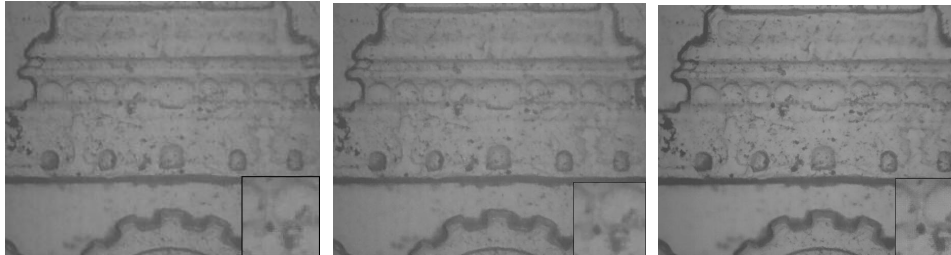
Figure 13. Experimental result. ( a ) low-resolution thermal microscope image (SNT = 5.4627); ( b ) Bilinear amplification image (SNT = 5.6503); ( c ) Micro-scan reconstructed image (SNT = 5.7148).